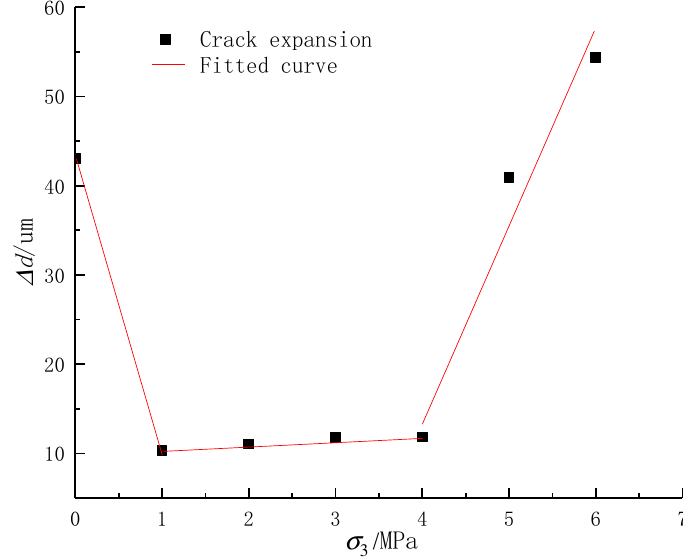
Figure 4. Curve of fracture width vs. confining pressure of coal samples after a 3-cycle liquid nitrogen injection.